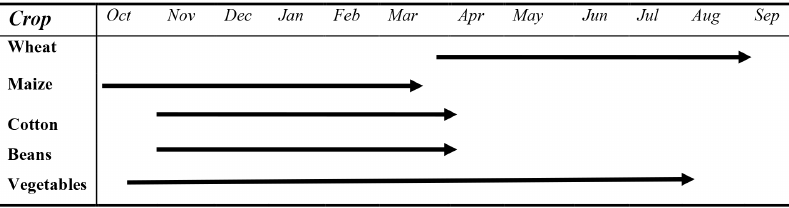
Figure 2. Typical cropping pattern and calendar at Mushandike Irrigation